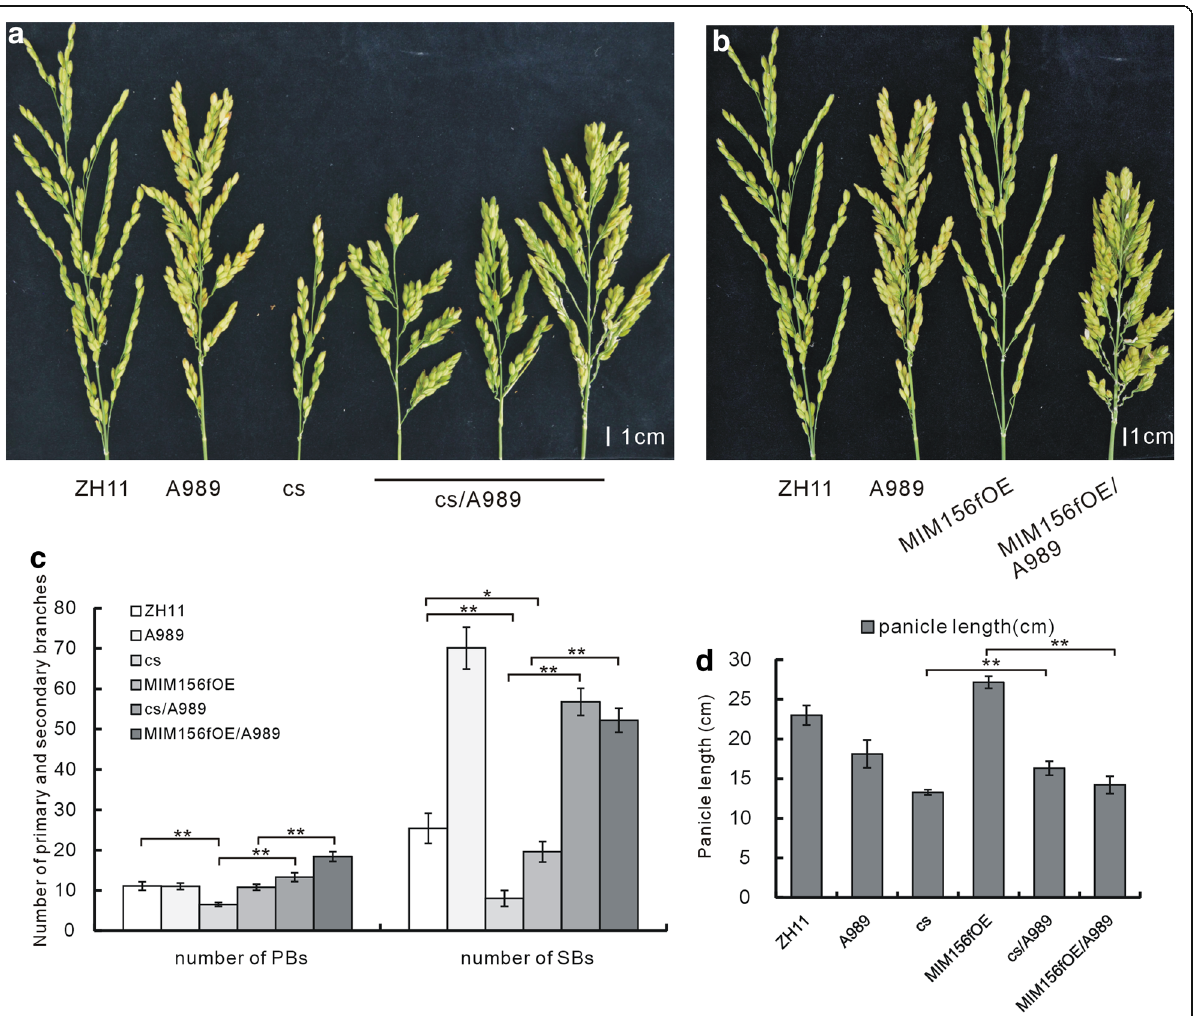
Fig. 5 Panicle phenotype of the hybrid of A989 and MIM156fOE, A989 and the cs mutant. a The panicle morphology of the cs and the A989 mutants, their cross, and the WT. b The panicle morphology of the MIM156fOE, the A989 mutant, their cross, and the WT. c Statistical analysis of the number of PBs and SBs in the A989 mutant, the cs mutant, the MIM156fOE plant, the cs/A989 cross, and the MIM156fOE/A989 cross ( n = 20). d Statistical analysis of the panicle length in the A989 mutant, the cs mutant, the MIM156fOE plant, the cs/A989 cross, and the MIM156fOE/A989 cross ( n = 20). Single and double asterisks represent significant difference determined by the Student ’ s t -test at * P < 0.05 and ** P <